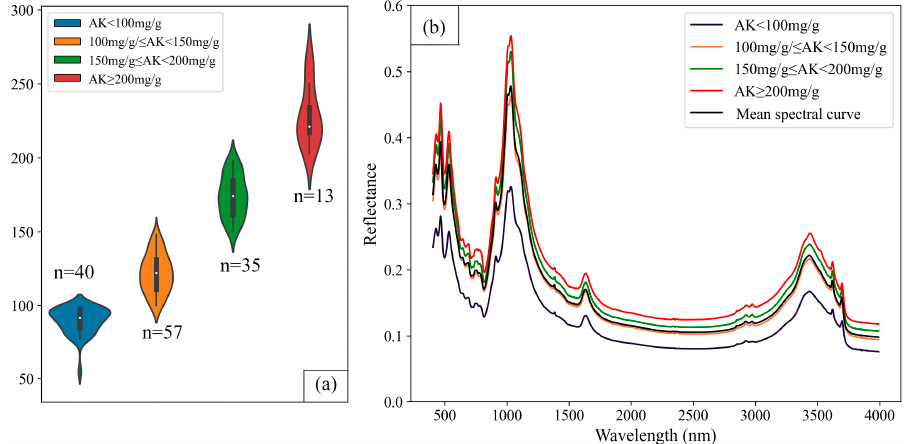
Figure 3. Data distribution and spectral re fl ectance of soil samples. ( a ) Violin plots (displays the distribution of the data along with the associated probabilities) of soil available potassium for different grades, where n represents the number of soil samples, and ( b ) variation trend of average soil spectral re fl ectance in di ff erent soil available potassium grades.